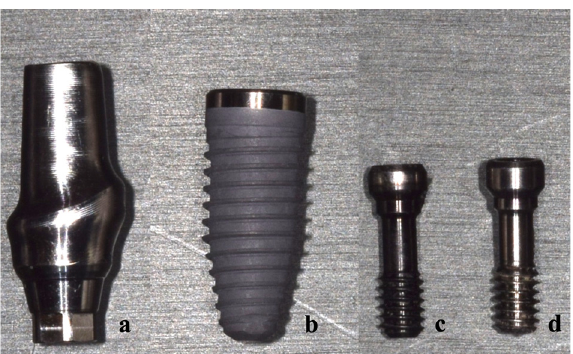
Figure 1. Components of the abutment–screw–implant system: ( a ) titanium abutment, ( b ) implant fixture, ( c ) OEM abutment screw, and ( d ) aftermarket abutment screw.